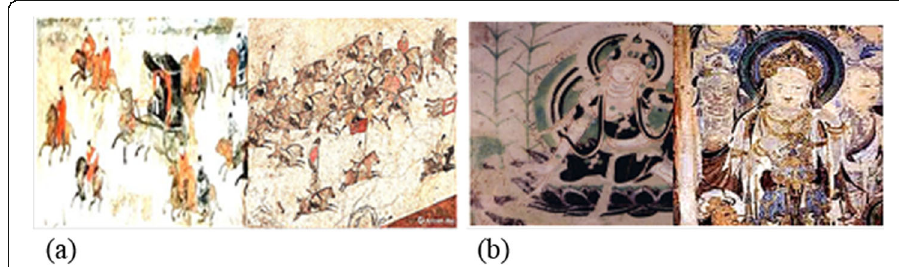
Fig. 17 Example of misclassification of similar mural content. a The mural created in the Qin/Han Dynasties is misclassified as the Sui/Tang Period (left) and that created in the Sui/Tang Period is misclassified as the Qin/Han Dynasties (right). b The mural created in the Song/Jin Period is misclassified as the Sui/Tang Period (left) and that created in the Sui/Tang Period is misclassified as the Song/Jin Period (right)